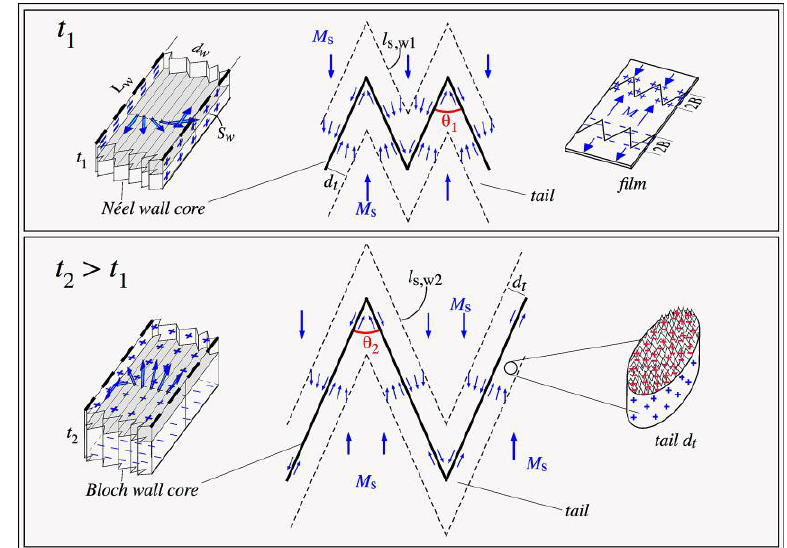
Figure 9. Schematic of two saw-tooth walls for Fe films with thicknesses t 1 < t 2 . Walls are composed of a core and a tail. Wall angles were θ 1 and θ 2 , respectively, with θ 1 > θ 2 , as our experimental results revealed; segment lengths were l s,w1 and l s,w2 , with l s,w1 < l s,w2 , also according to the experimental results. At low thickness, the core had a Néel-type wall, with magnetization rotation within the wall in the film plane. At higher thickness, it had a Bloch-type wall, with magnetization out-of-plane rotation. Details of the two cores are shown (left side). Core wall width was d w and tail width was d t , which were assumed to be thickness independent; see text for explanation. Magnetization rotation in the tail was also produced in the film plane. Representation of surface roughness with corresponding poles at the wall tail is shown on the right.